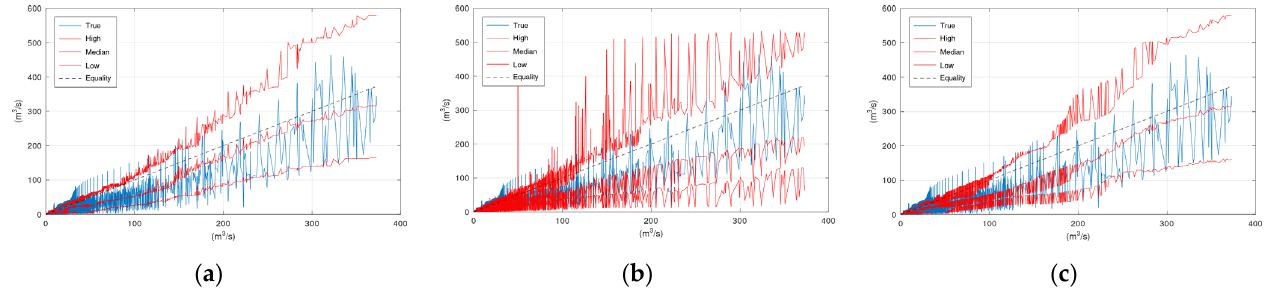
Figure A2. Scatter plot of the KNN application in the Sieve River case study during the validation period: ( a ) 2D Option 1; ( b ) 2D Option 2; ( c ) 2D Option 3.